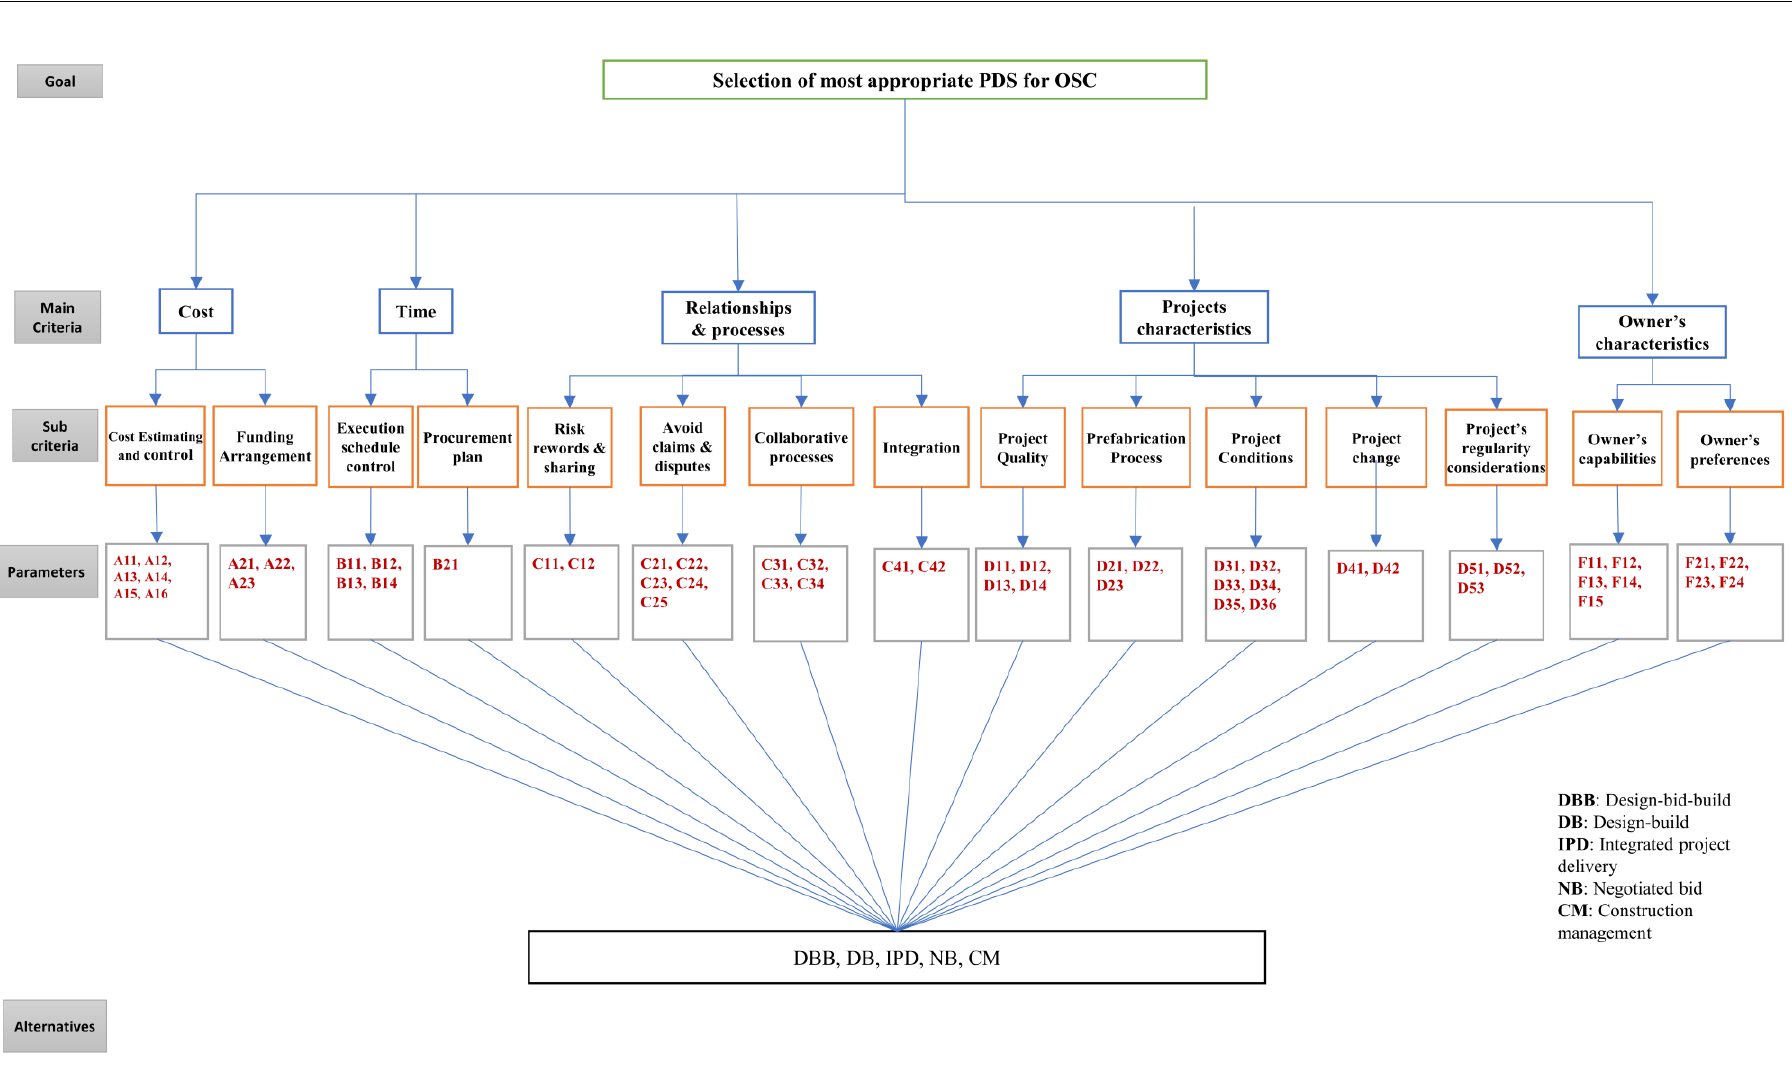
Figure 3. Decision tree matrix to display main criteria, sub-criteria, parameters, and alternatives .